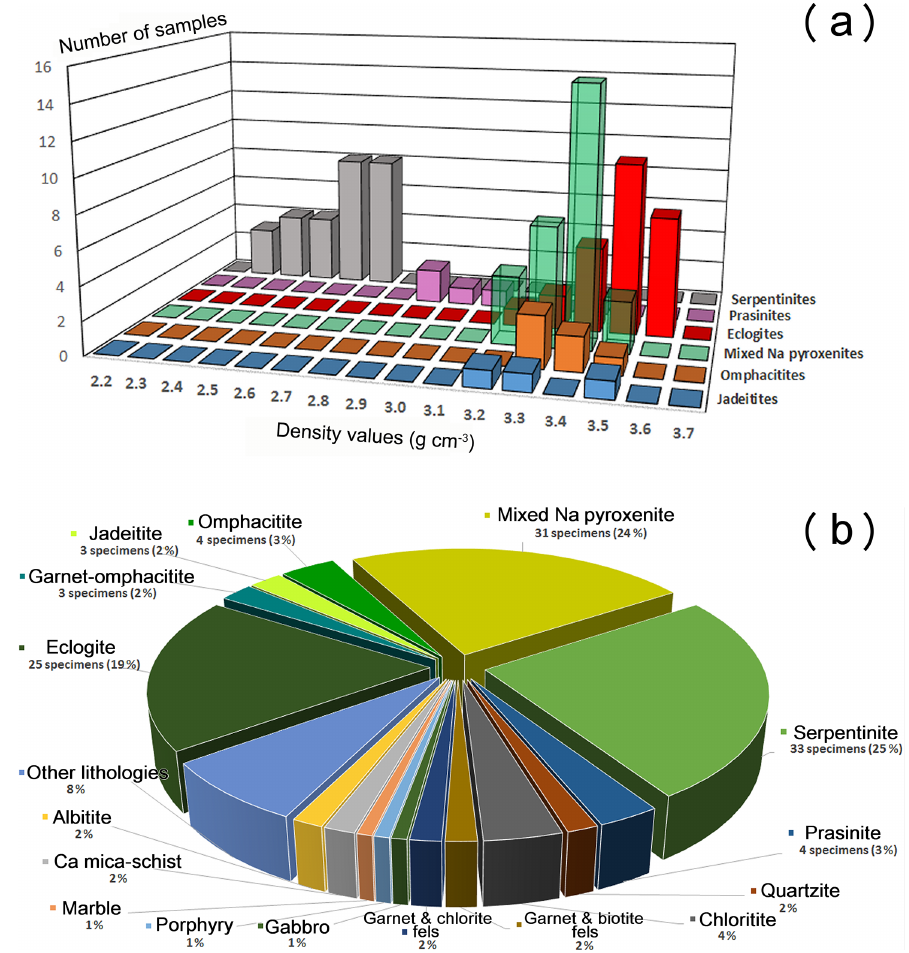
Figure 3. (a) Histogram of density measurements, performed on 119 (out of 132) lithic implements from Chiomonte. (b) Preliminary lithotype distribution of the 132 tools from Chiomonte, obtained by combining stereo-microscopic observations and density